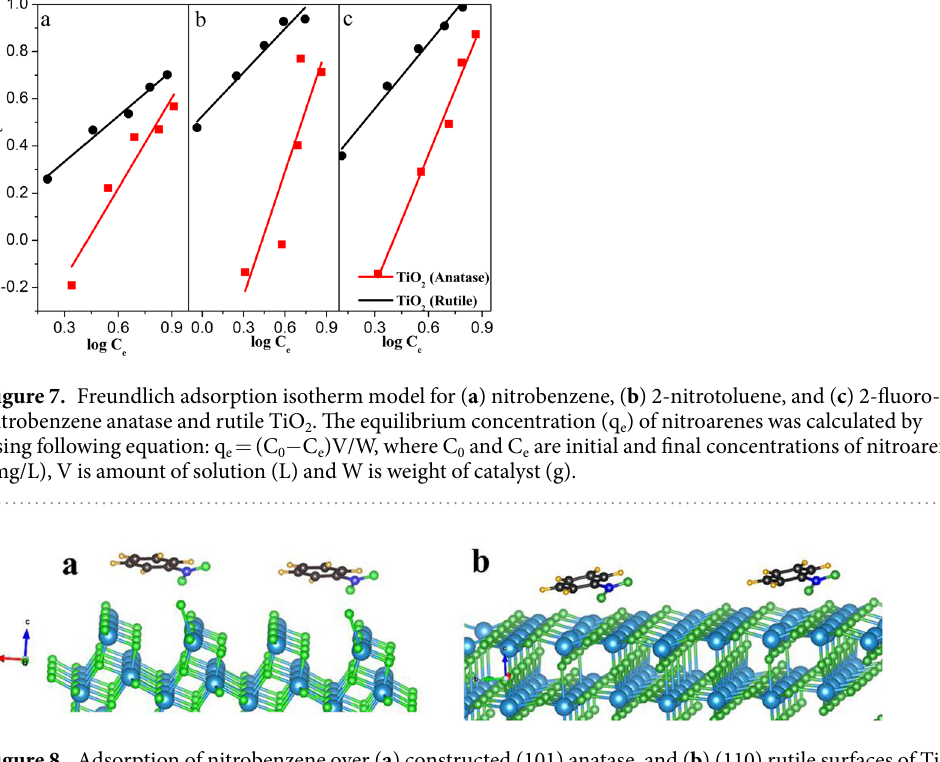
Figure 8. Adsorption of nitrobenzene over ( a ) constructed (101) anatase, and ( b ) (110) rutile surfaces of TiO 2 .